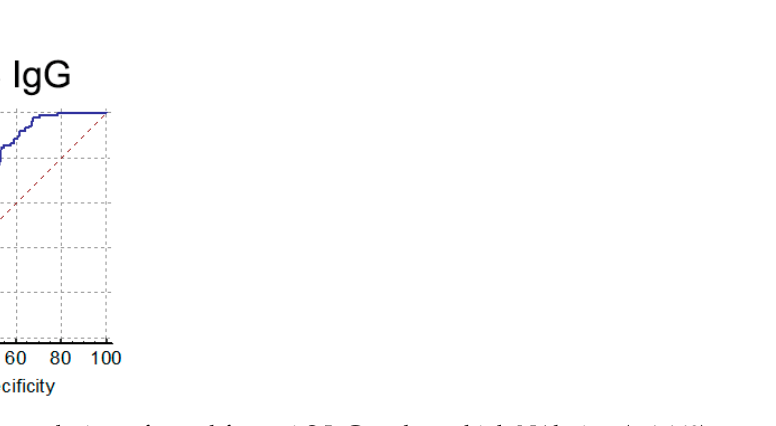
7 of 12 Figure 4. Anti-SARS-CoV2 IgG correlation to NAb titers. Total anti-SARS-CoV-2 (left panel), anti-Spike (anti-S) (central panel), and anti-Nucleoprotein (anti-N) (right panel) IgG levels were compared to NAb titers. Horizontal dot line indicates limit of NAb level quantification, vertical dot line indicates the limit of IgG detection. Spearman’s test was used for correlation analysis.